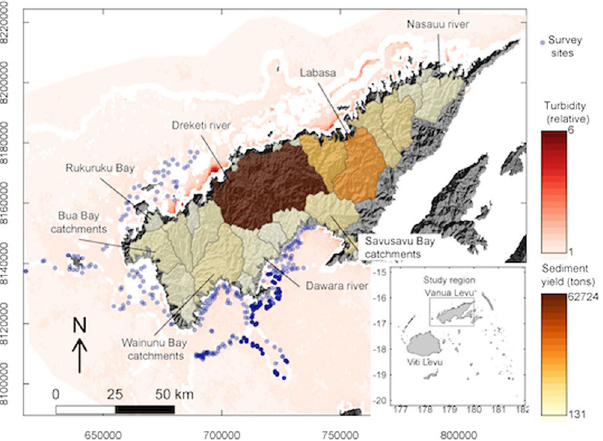
Figure 1. Map of the study region, showing grouped catchments (coloured polygons, overlaid on a hillshade map) with their estimated sediment yield (tons per wet season) and reef survey sites. White areas were excluded from analysis due to shallow water or being too far from the catchments. Ocean colour scale shows mean turbidity estimated from satellites. Inset shows the study region’s location in relation to Fiji’s largest islands. The maps were created using the spatial data described in text and the R programming language (R: A language and environment for statistical computing. v3.3.2 (R Foundation for Statistical Computing, Vienna, Austria., 2016). https://cran.r-project.org) 26 , including the packages sp (Pebesma, E. J. & R.S., B. Classes and methods for spatial data in R https://cran.r-project.org/doc/Rnews/. R News 5 (2005)) 48 and rgdal (Bivand, B., Keitt, T. & Rowlingson, B. rgdal: Bindings for the Geospatial Data Abstraction Library. R package version 1.2–5. (2016). https://CRAN.R-project.org/package = rgdal) 49 .